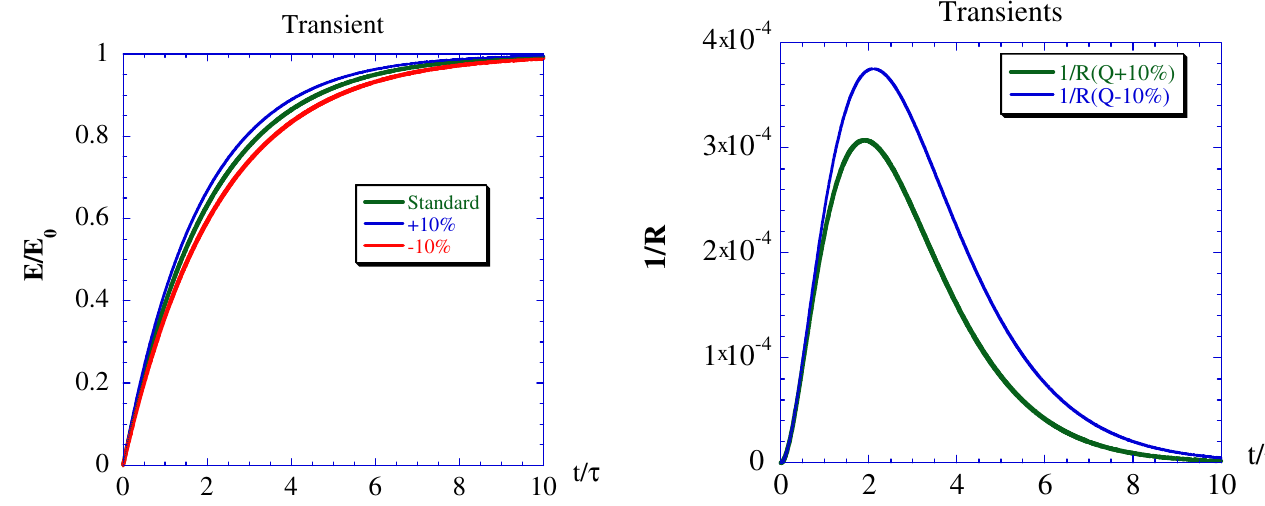
FIG. 6. (Color) Transient of the electric fields (left graph) and the efficiencies of evanescent wave cancellation during turning-on cavities with (cid:10) 10% variation of Q L